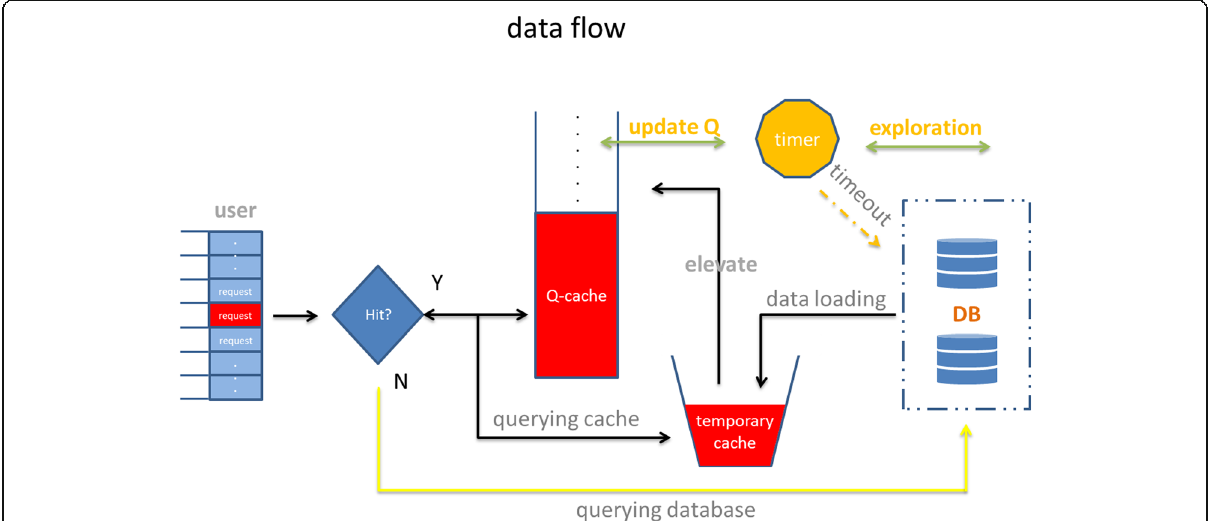
Fig. 2 TQC algorithm structure. On the one hand, TQC listens to the user request to determine whether the cache is hit. a If it is hit, the result will be returned directly to the user and the Q value of the action will be updated. b If it is missed, the data in the file system or DB will be loaded to the temporary cache and one or several pieces of data with the smallest Q value in the temporary cache will be replaced. On the other hand, TQC periodically (at a specific stride) adds data to the temporary cache from the list of known contents, replaces one or several files with the smallest Q value, and then observes the change of cache hit ratio so as to allow TQC to learn user requests with low frequency and long period and achieve direct